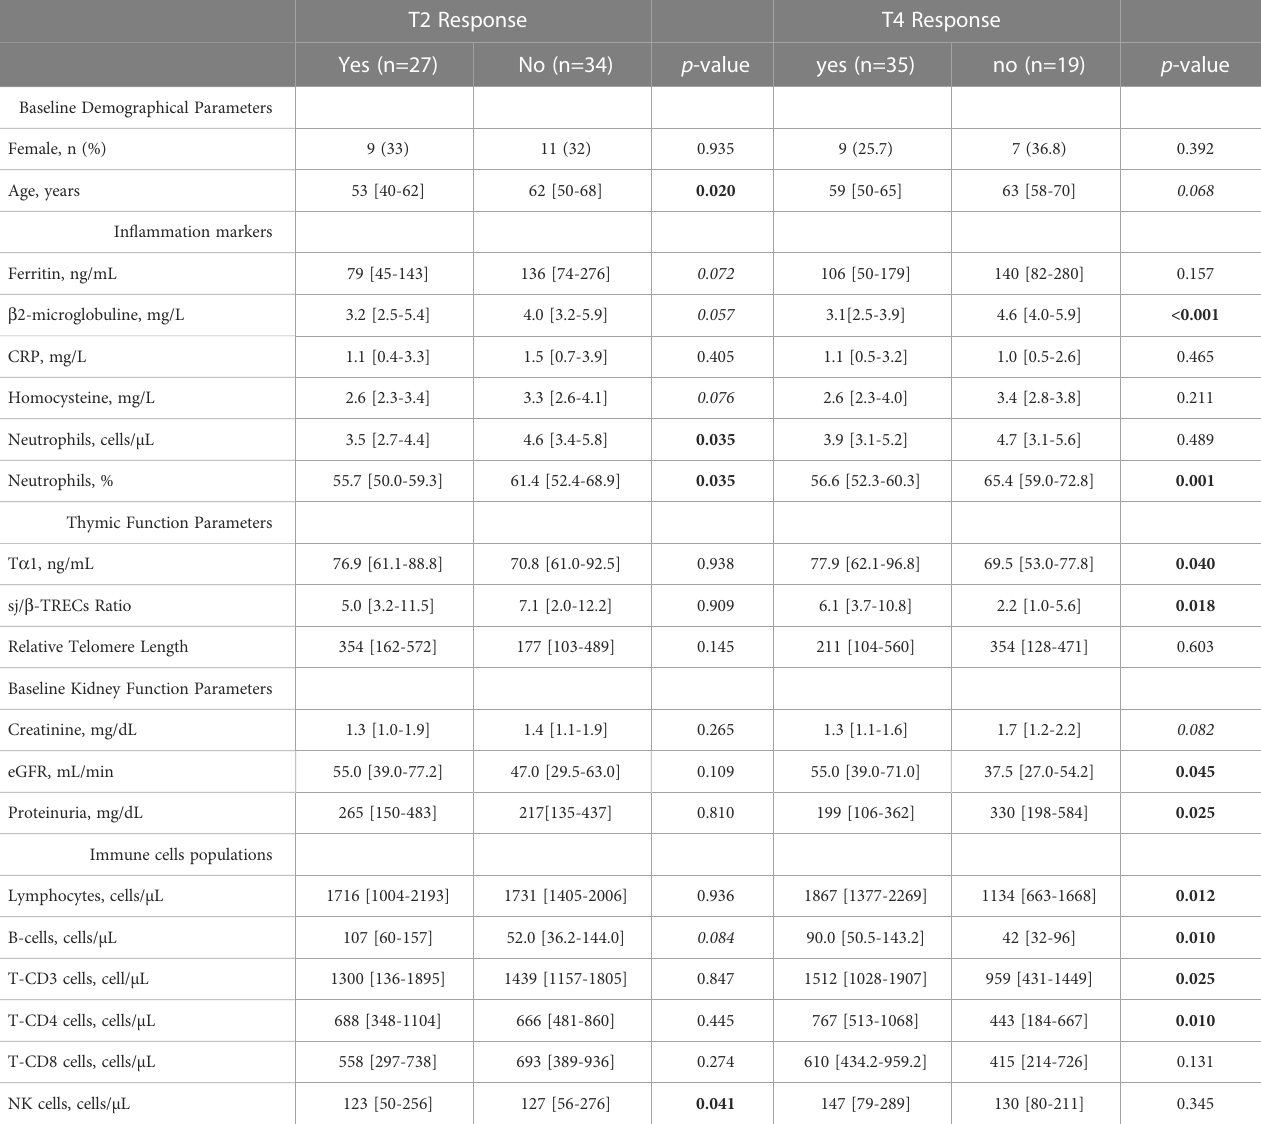
TABLE 2 Analysis of soluble markers in KTR depending of their humoral response to COVID-19